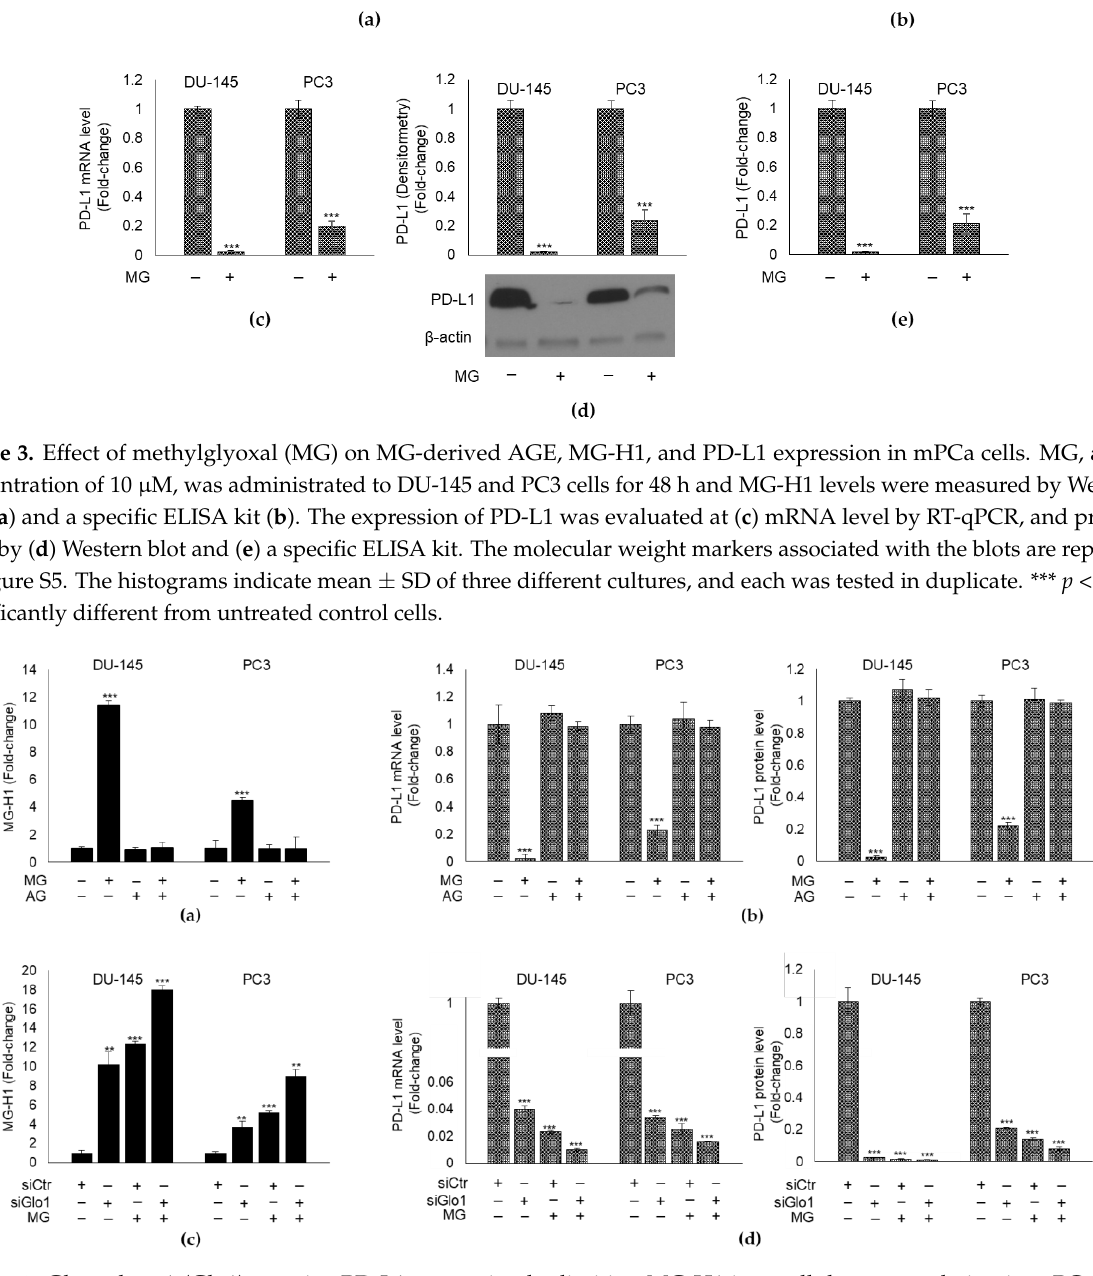
Figure 4. Glyoxalase 1 (Glo1) sustains PD-L1 expression by limiting MG-H1 intracellular accumulation in mPCa cells. DU-145 and PC3 mPCa cells were exposed to 10 µM MG for 48 h after a pre-treatment with 1 mM aminoguanidine (AG) for 48 h and ( a ) MG-H1 intracellular levels were measured by a specific ELISA kit, while ( b ) PD-L1 expression was evaluated at mRNA level and protein level by RT-qPCR and a specific ELISA kit, respectively. The effect of Glo1 silencing (siGlo1) or siCtr (negative control) was evaluated on ( c ) MG-H1 and ( d ) PD-L1 levels measured as above. The histograms indicate mean ± SD of three different cultures, and each was tested in duplicate. (-) untreated and (+) treated cells. ** p < 0.01; *** p < 0.001 significantly different from control cells.